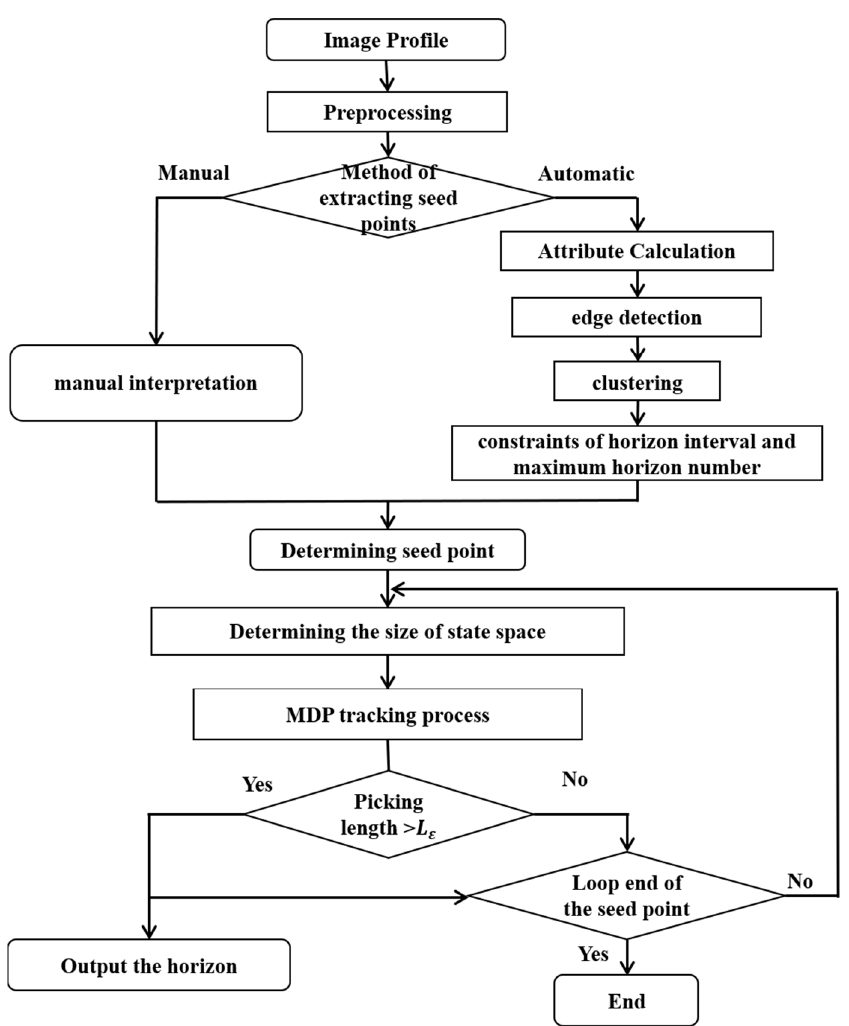
Figure 4. The flowcharts for the horizon picking of the proposed method.